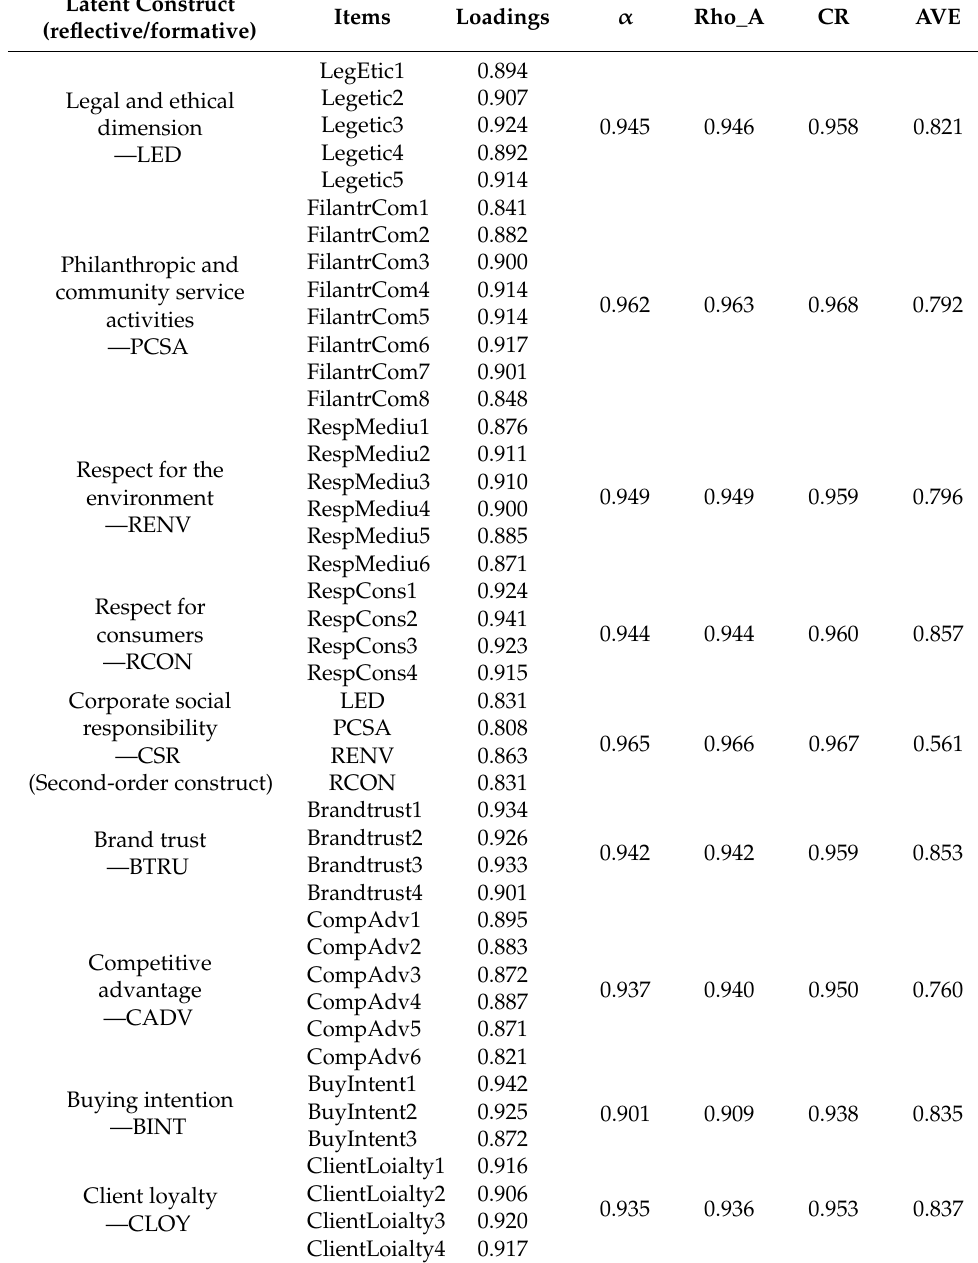
Table 3. Construct reliability and